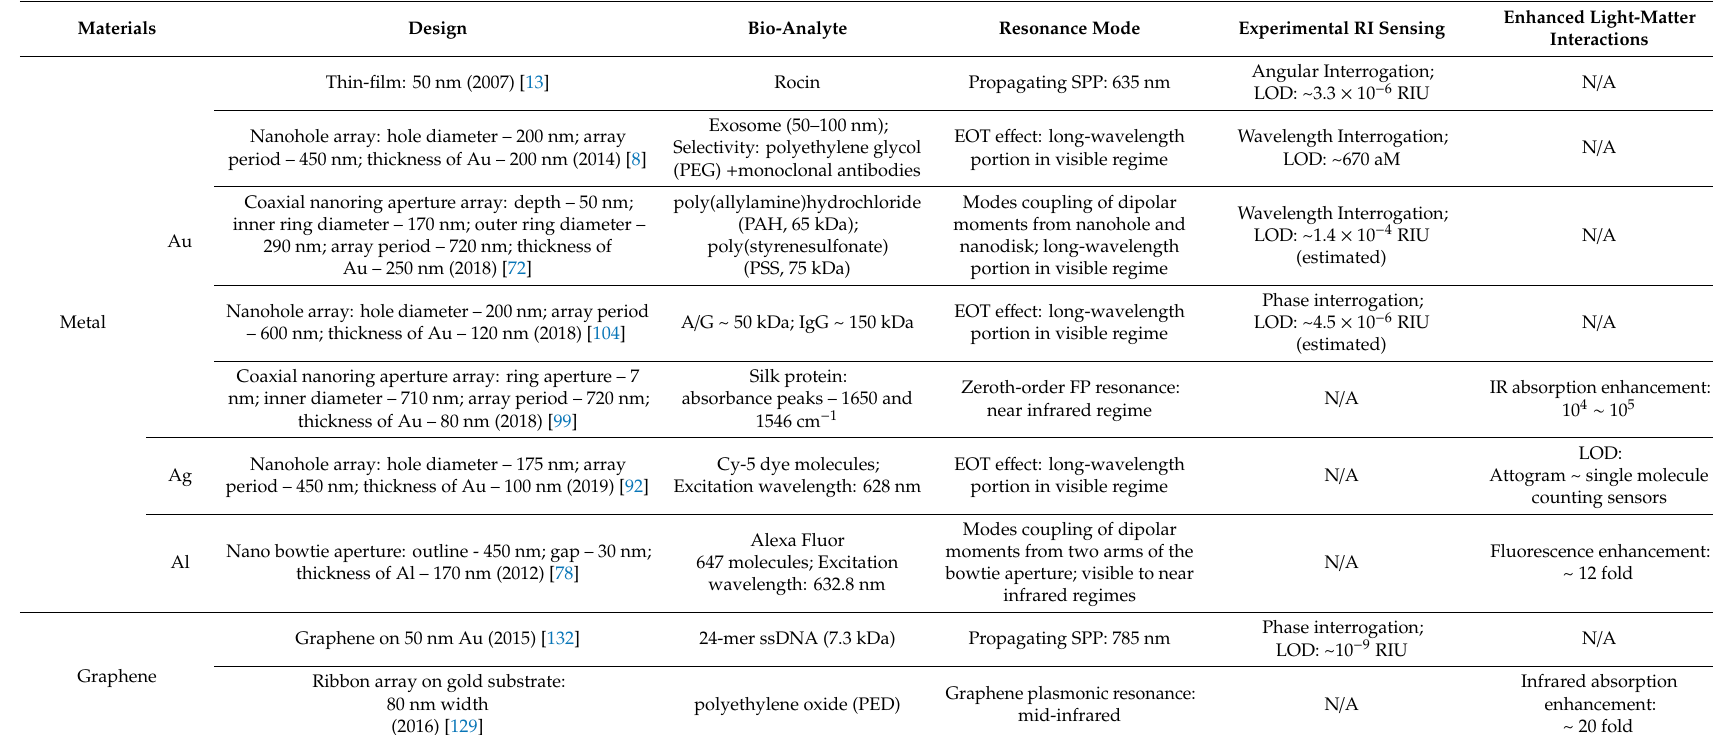
Table 1. Plasmonic biosensors based on di ff erent